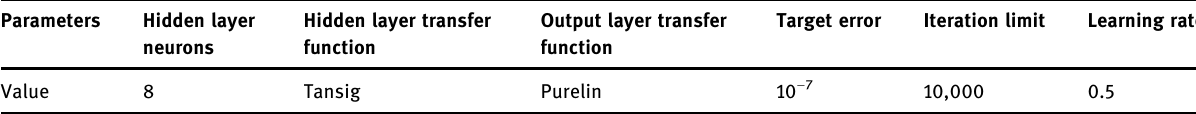
Table 2: BP neural network parameters